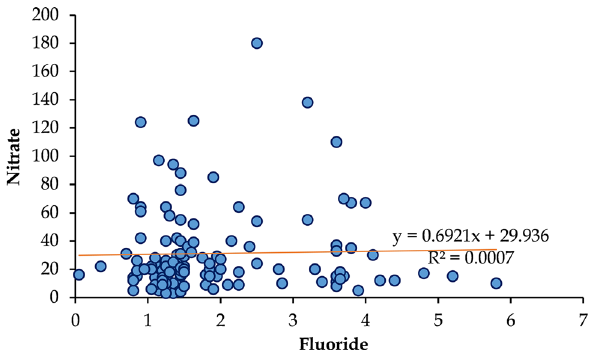
Fig. 8 Correlation between fluoride and nitrate in the groundwater of Markapur, India